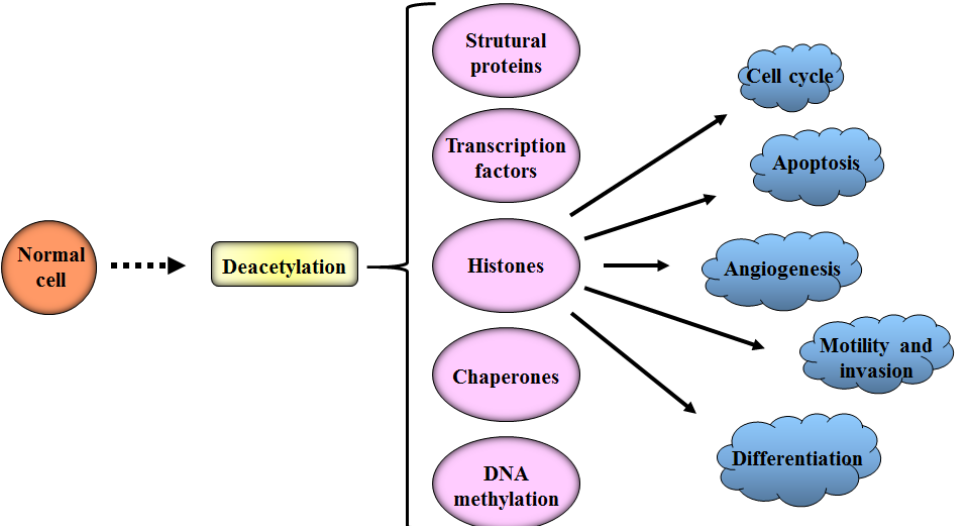
Figure 5. Some pathways that are altered by the activity of histone deacetylases. Acetylation